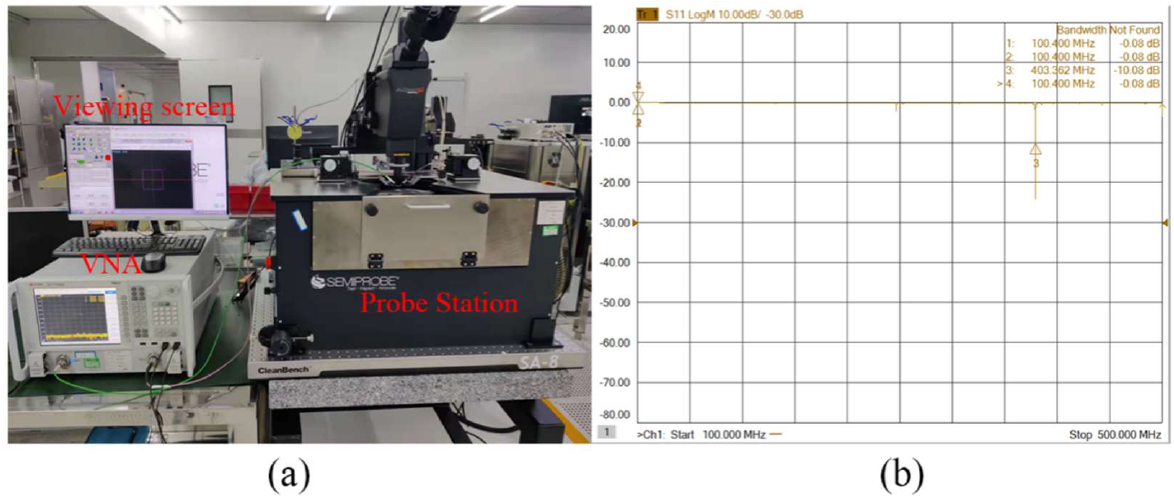
Figure 6. ( a ) Schematic diagram of the testing equipment for the fabricated LWRs; ( b ) measured S 11 spectrum of a fabricated LWR.